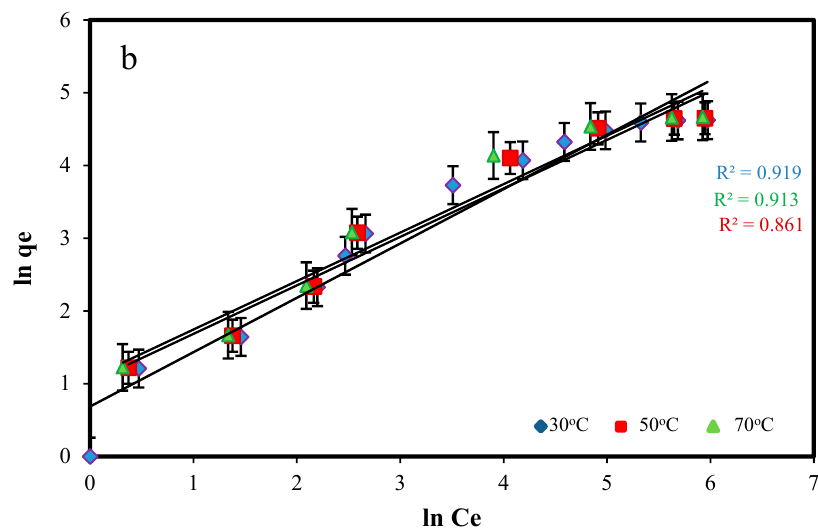
Figure 7. Linearized Langmuir ( a ) and Freundlich ( b ) isotherms for Pb(II) adsorption onto ZnO-Nano-A at various temperatures: contact time, 1 h; initial pH, 5.0; adsorbent mass: 0.1 g L − 1 . Table 2. Isotherm constants of Pb(II) adsorbed onto ZnO-Nano-A. Langmuir Isotherm Freundlich Isotherm Temp ( ◦